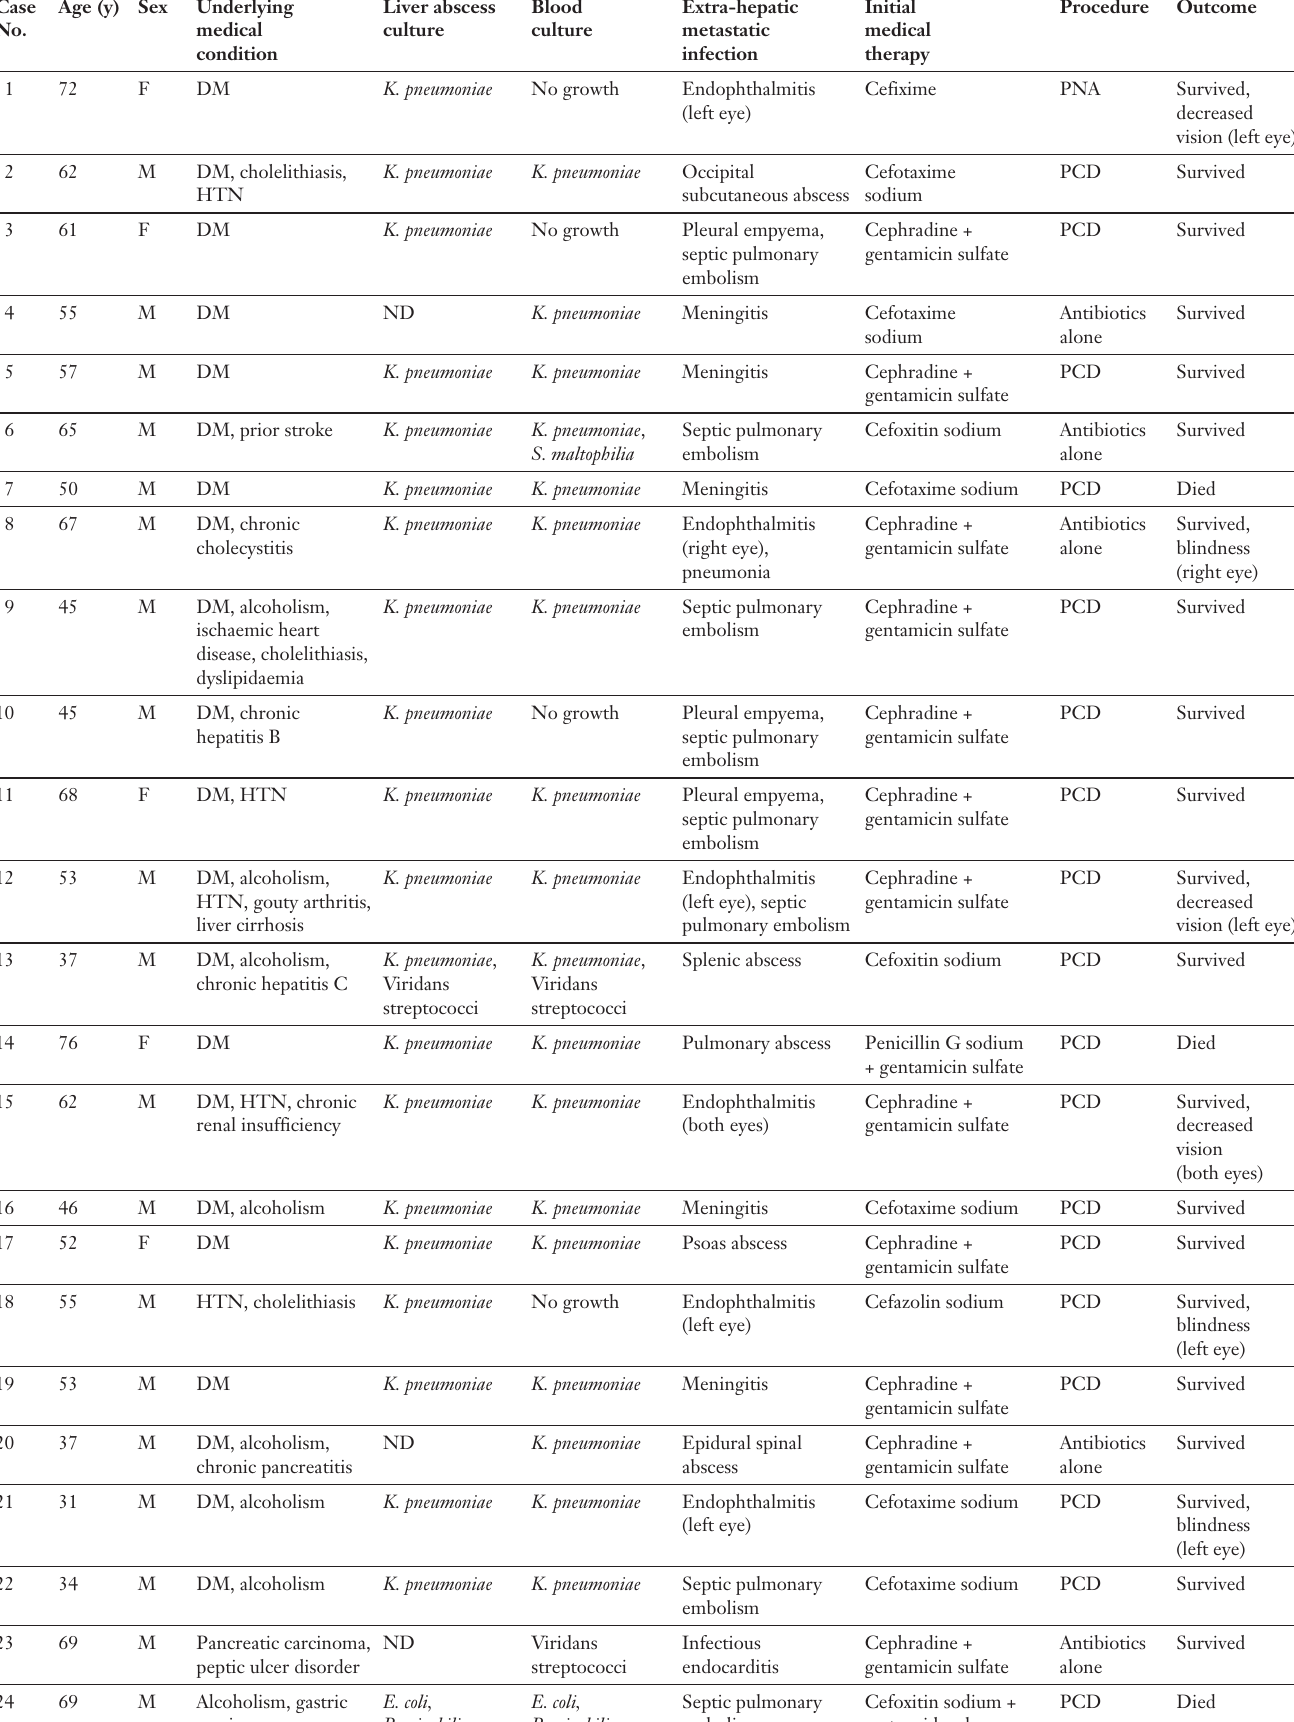
Table 1 Pyogenic liver abscess cases with extra-hepatic